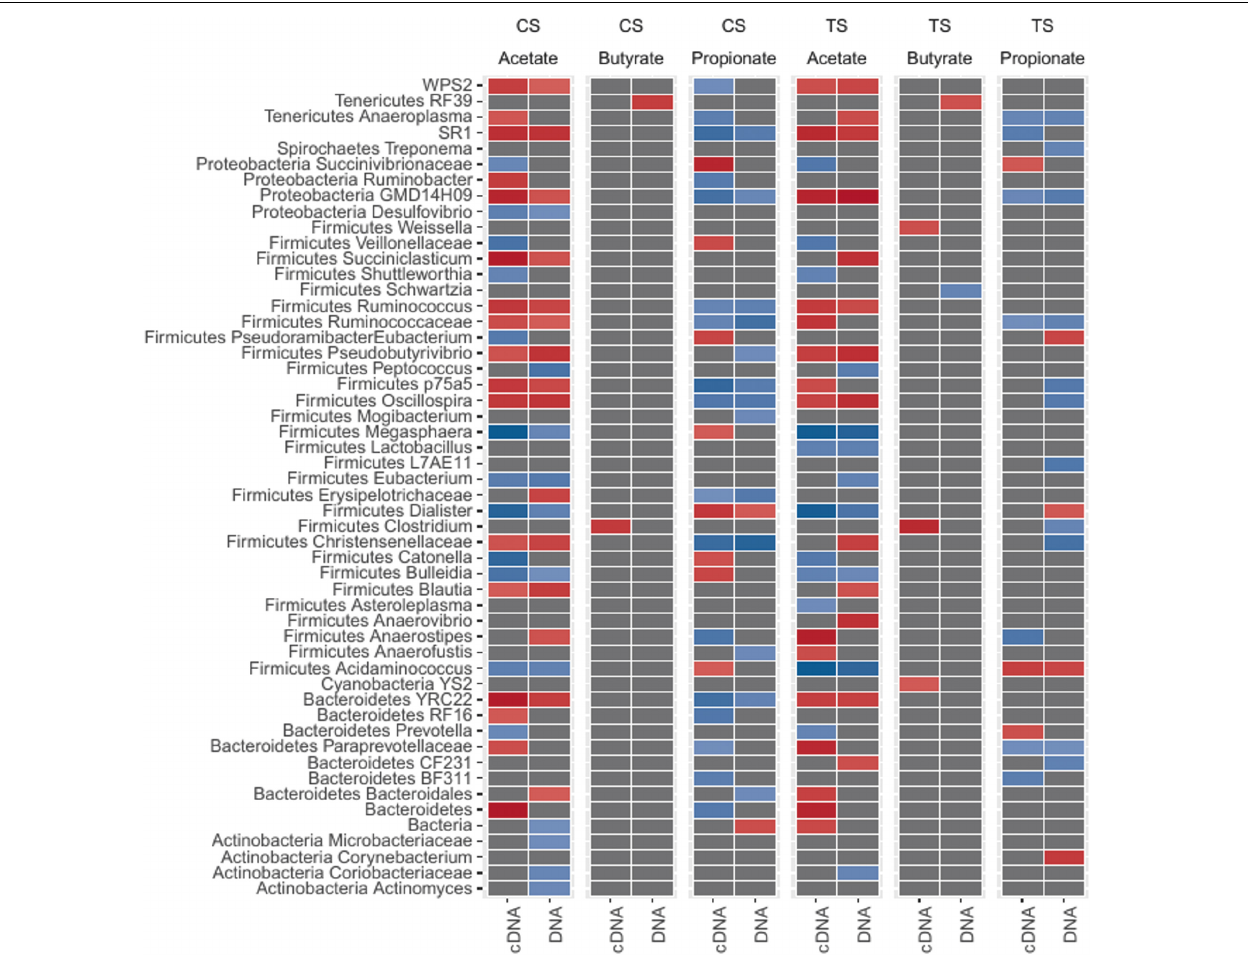
FIGURE 4 | Association pattern between bacterial genera and VFA (volatile fatty acids; acetate, butyrate, and propionate) based on Spearman’s correlations. Abundant bacterial taxa were selected (ANCOM test) and correlation coefficients (r) greater than 0.6 (+ve or –ve) and P ≤ 0.01 were considered significant. The red color indicates positive correlations (ranged from 0.6 to 0.8). The blue color indicates negative correlations (ranged from –0.6 to